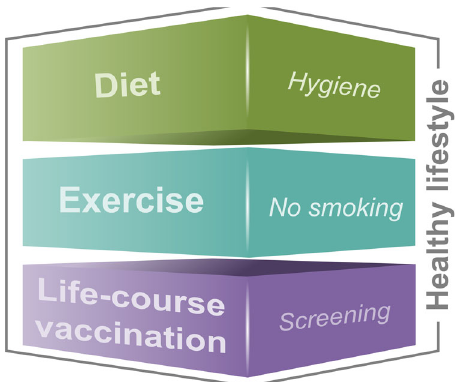
Fig. 2 Healthy lifestyle pyramid adapted from Philip et al. 5 Life- course immunization as a key component of a healthy lifestyle